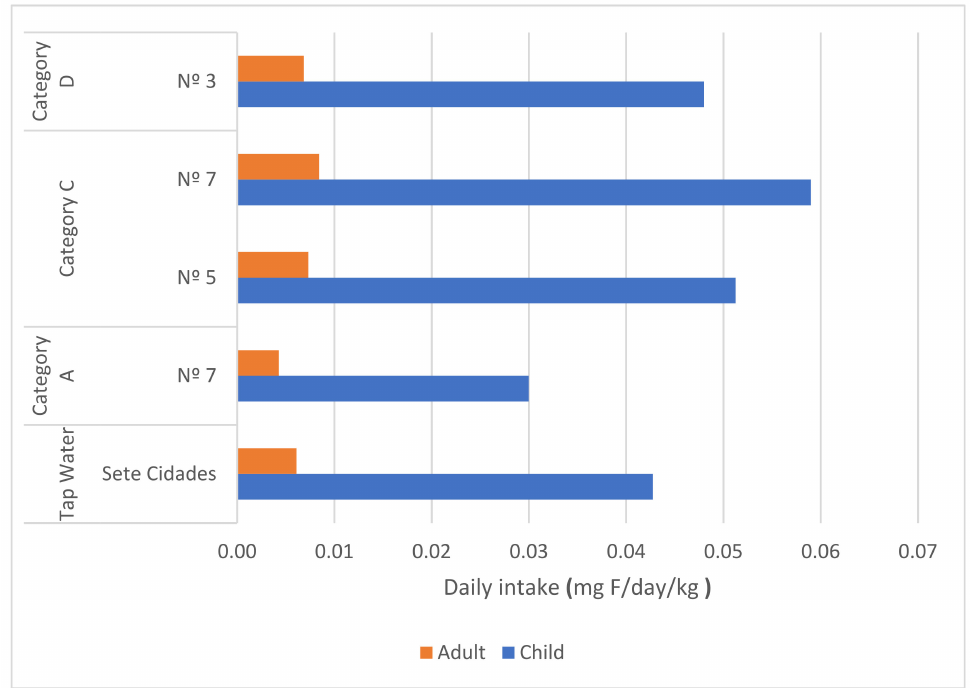
Figure 1. Daily intake assessment in a child and an adult considering the water sample’s fluoride mean concentration was higher than 1.2